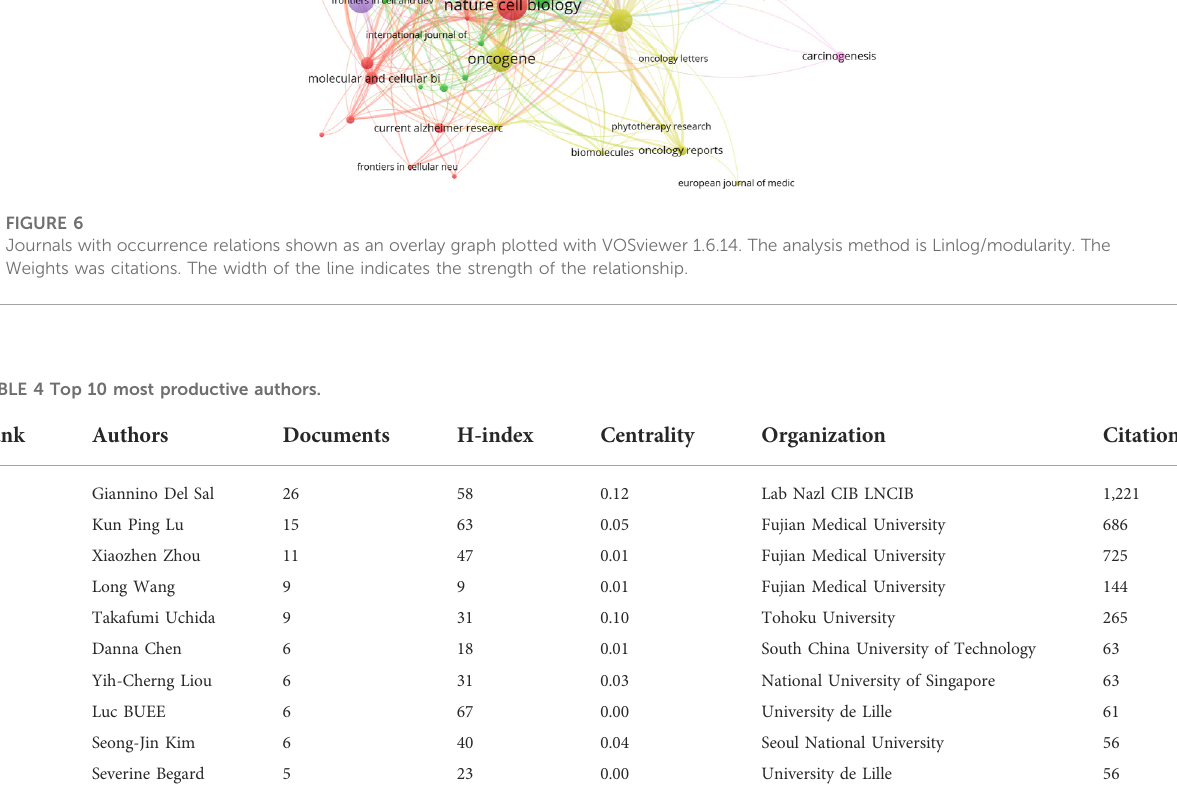
Keywords can prompt or express the characteristics of the topic content of this study. By analyzing the frequency and distribution of keywords, we can understand the hot trends in research. A total of 903 keywords were retrieved from 395 articles. VOSviewer was used to draw the knowledge graph of the keywords (Figure 8). The frequencies and centralities of the keywords are listed in Table 5. As shown in Table 5, high-frequency keywords were Pin1 (206), apoptosis (80), phosphorylation (78), breast cancer (63), cell cycle (48), Alzheimer ’ s disease (37), and p53 (30). Figure 8 shows the frequency of keywords through the size of the circle and the clustering of keywords through the circle color. Owing to the